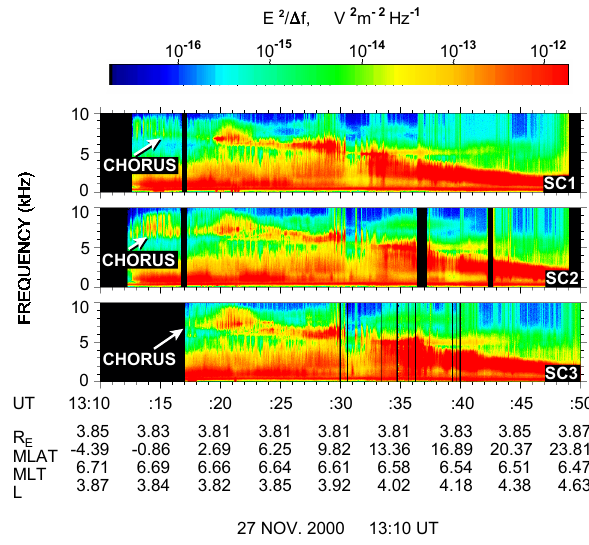
Fig. 4. Frequency-time spectrograms from three of the four Clus- ter spacecraft during the perigee pass on 27 November 2000. The highly structured emission from about 5 to 8kHz near the magnetic equator, extending from about 13:12 to 13:32UT, is chorus. The coordinates given at the bottom of the plot are the average of the coordinates of the three spacecraft (i.e. center of mass).